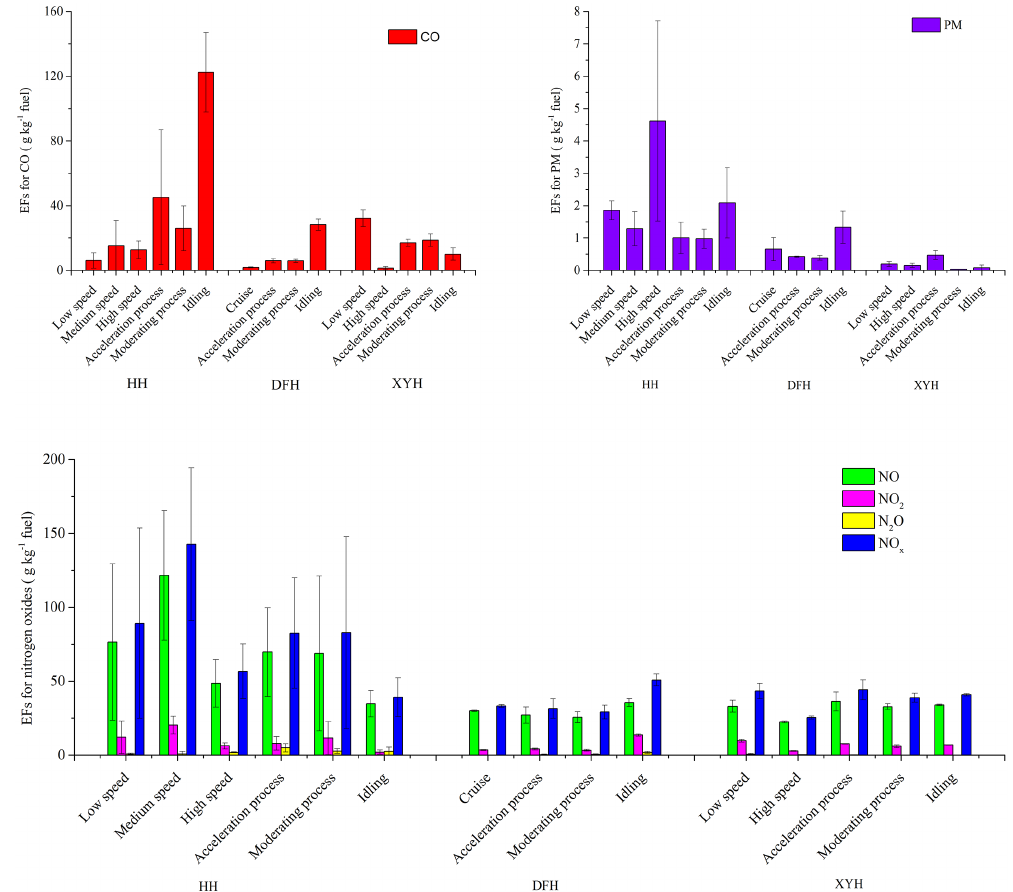
Figure 2. EFs for the typical pollutants in different operating